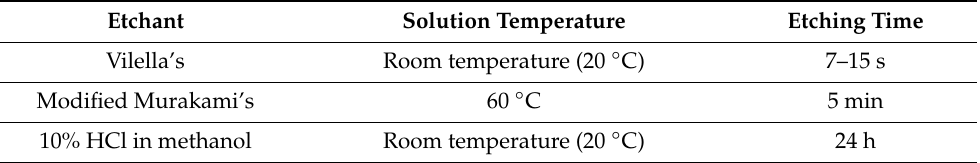
Table 2. Etching parameters for each